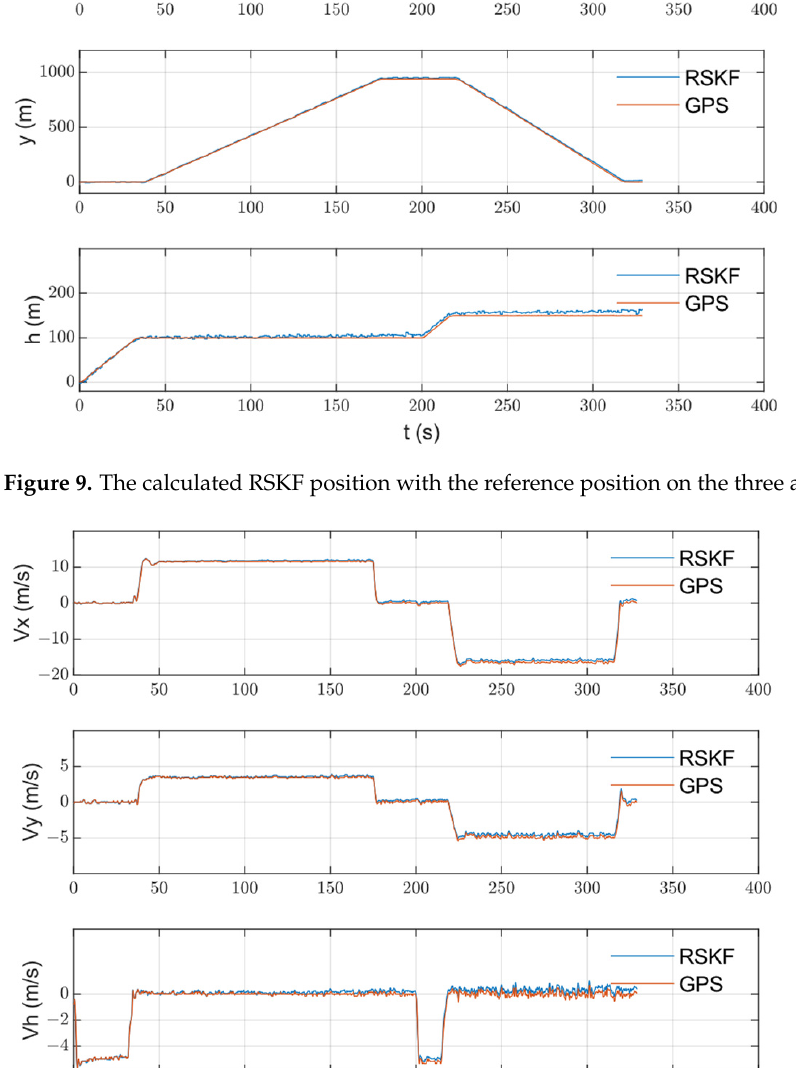
Figure 10. The calculated RSKF velocity with the reference velocity on the three axes.